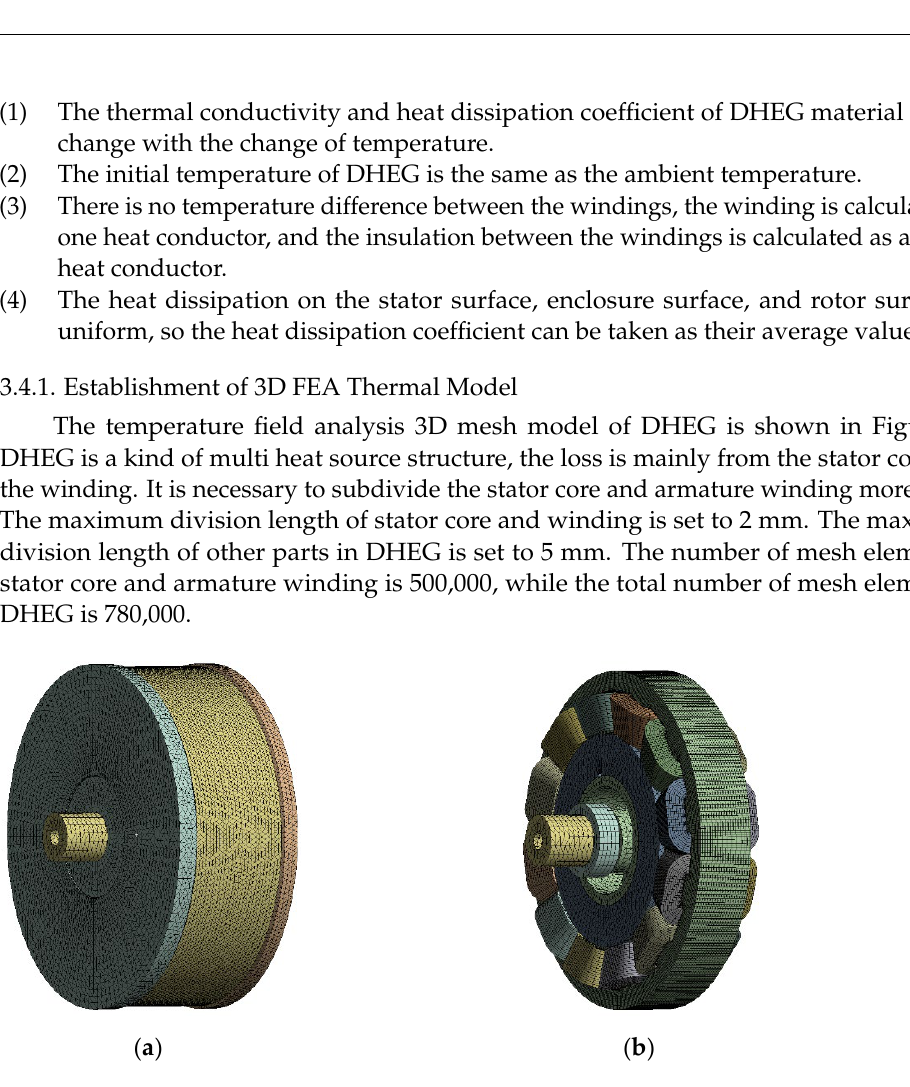
Figure 11. DHEG temperature field analysis 3D mesh model: ( a ) Overall model; ( b ) Stator and rotor model.